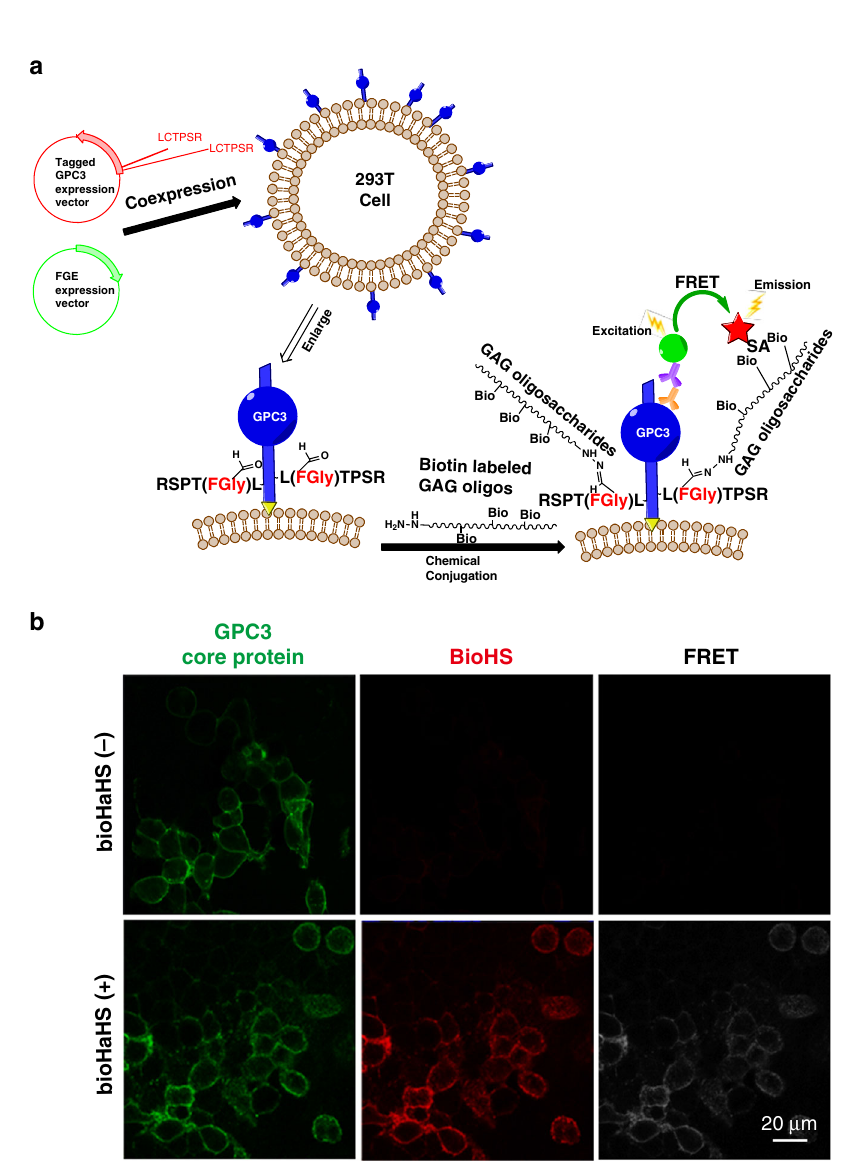
Fig. 3 Intramolecular FRET between GPC3-O and attached HS. a Diagram of the intramolecular FRET strategy for imaging HS side chains attached to GPC3-O. b FRET analysis of the GPC3 core protein and the attached HS chains. GPC3-O-transfected cells were incubated in the presence or absence of bioHaHS, and FRET was performed. This experiment was repeated three times with similar results. Scale bars: 20 μ